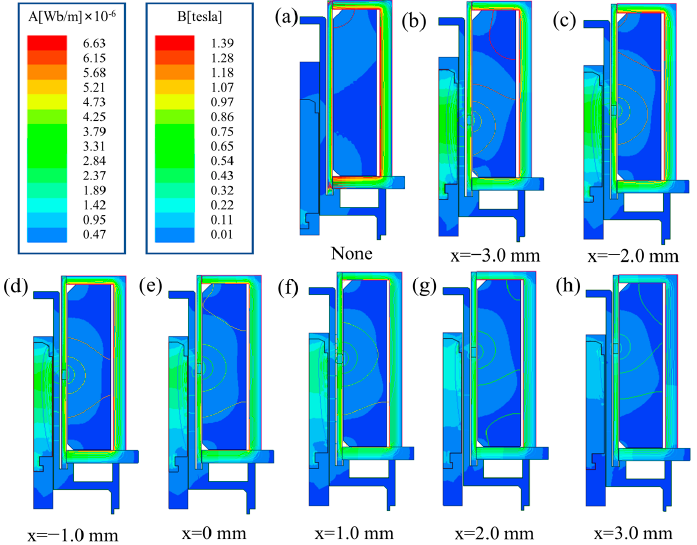
Figure 7. The distribution of the magnetic induction intensity at ( a ) without MIR and MIR’s position at ( b ) –3 mm, ( c ) –2 mm, ( d ) –1 mm, ( e ) 0 mm, ( f ) 1 mm, ( g ) 2 mm, ( h ) 3 mm at ( b ) − 3 mm, ( c ) − 2 mm, ( d ) − 1 mm, ( e ) 0 mm, ( f ) 1 mm, ( g ) 2 mm, ( h ) 3